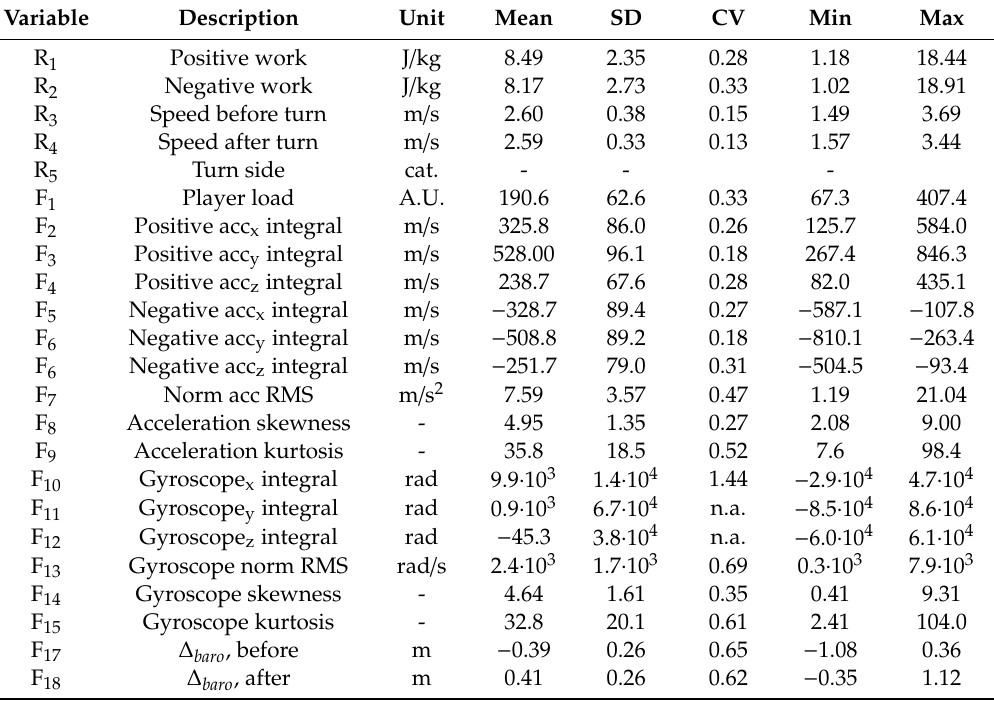
Table 1. Overview of the five responses ( R i , where R 5 is a categorical variable) and of the 18 features ( F i ) used to train the